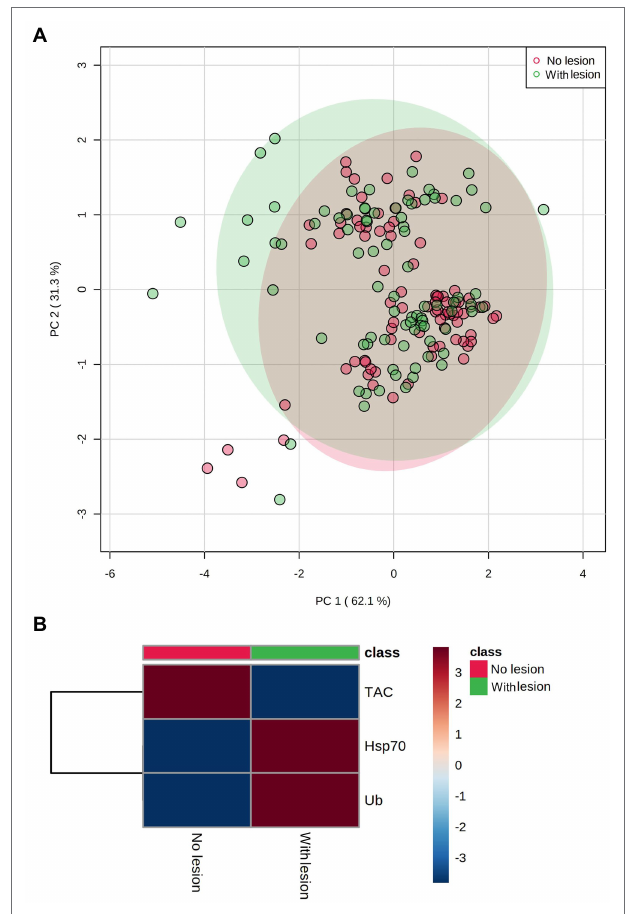
FIGURE 2 | Differences in biomarker profiles of seven Scleractinian coral species tested in this study. (A) PCA score plot of biomarker profiles; (B) heatmap of clustered biomarkers; in the color scale, red indicates higher than mean concentration, and blue indicates lower than mean concentration. Rows are biomarker concentrations and columns are group averages. Significant differences were found for biomarker profiles between species ( Table 2 ).